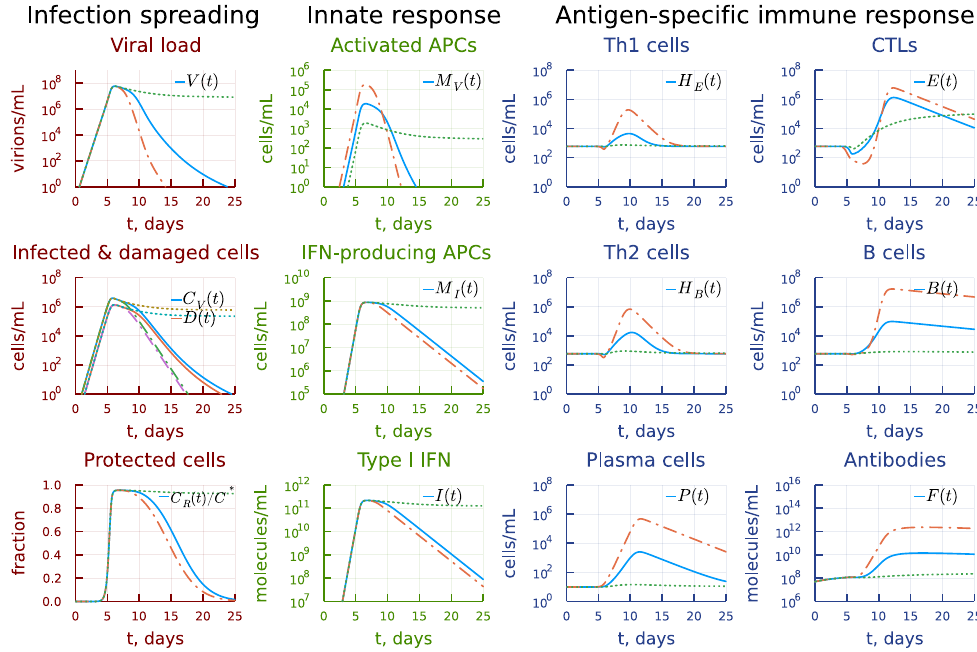
Figure 8. Effect of the rate constant of the antigen presenting cell stimulation. Dashdot: 10-fold increase of γ MV , dot: 10-fold decrease of γ MV relative to baseline